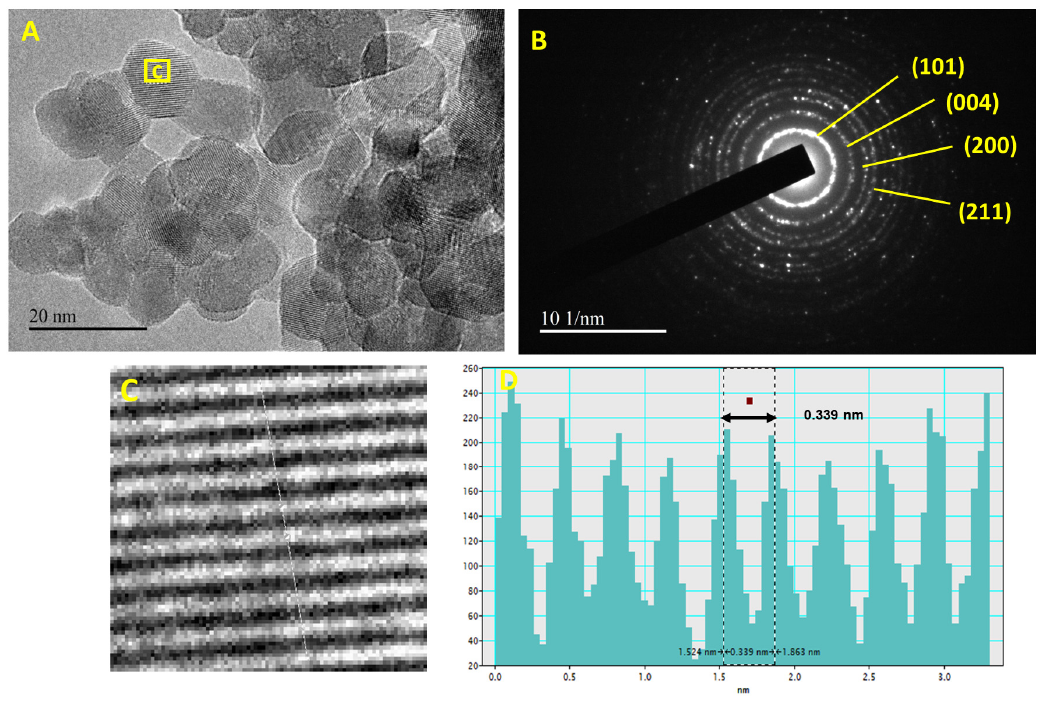
Figure 2. ( A ) TEM images of the pseudo dumbbell shape PdO.TiO 2 nanoparticles at 20 nm; ( B ) SAED pattern; ( C ) inverse FFT image; ( D ) profile graph of inverse FFT image.